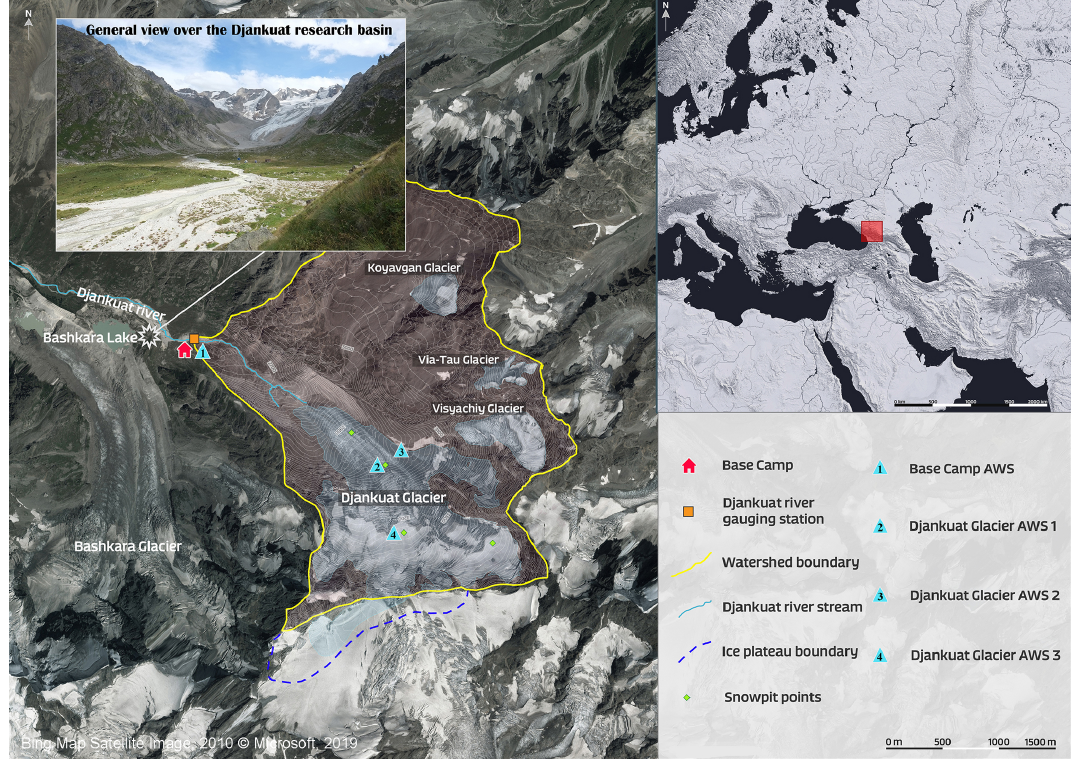
Figure 1. The Djankuat River basin with the depicted location of the base camp, main weather stations, snow pits, and the Djankuat River gauging station. Table 1. Location of main sites within the Djankuat research basin.